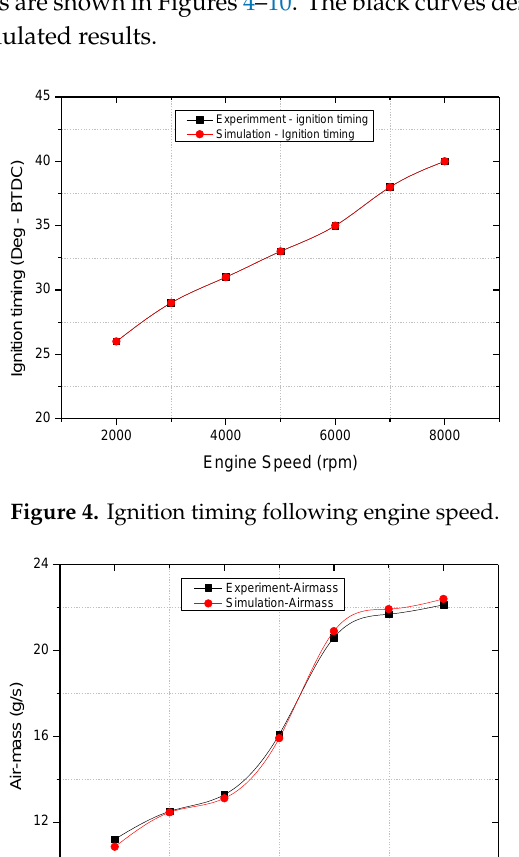
Figure 5. Air mass flow following engine speed.